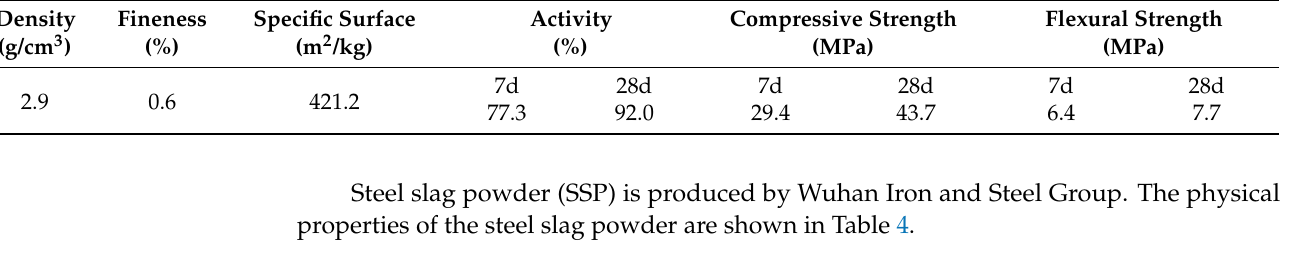
Table 4. Physical properties of the steel slag